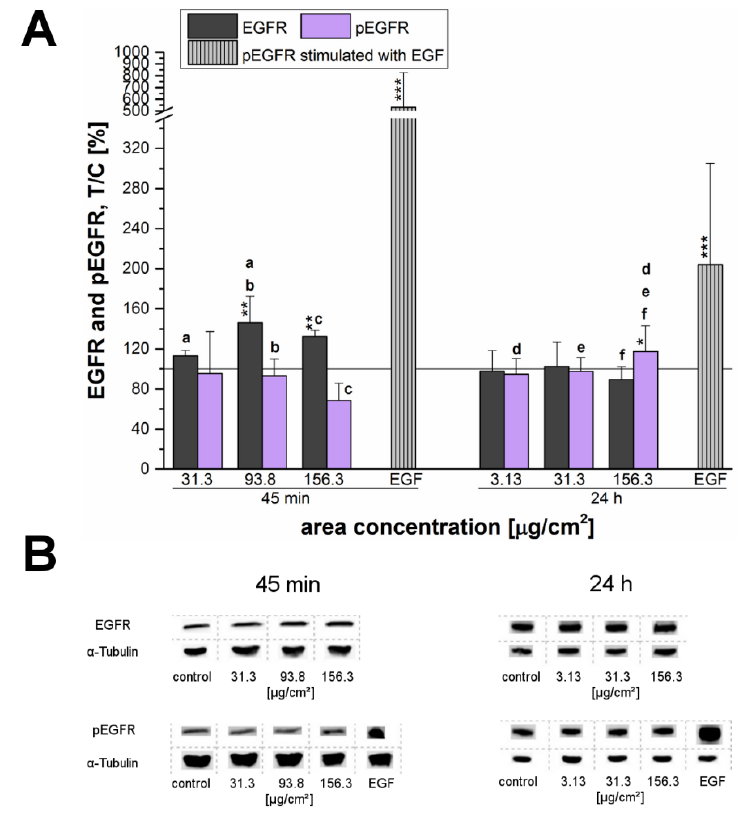
Figure 7. Endogenous epidermal growth factor (EGF) receptor levels and their activation status (pEGFR) in GXF251L cells after 45 min and 24 h of incubation with 12 nm SiO 2 NPs. EGF was applied as a positive control for phosphorylation of EGFR. ( A ) The relative amount was quantified as arbitrary light units in relation to the negative control (T/C [%]). The solid line represents the negative control set to 100%; ( B ) Representative images of a Western blot experiment. α-Tubulin was used as loading control and detected on the same membrane. Statistical analysis was obtained by one-way ANOVA followed by Fisher’s LSD test. Significances indicated as * refer to a comparison to the respective negative control (* ≡ p ≤ 0.05; ** ≡ p ≤ 0.01 and *** ≡ p ≤ 0.001; n ≥ 3). The same letters indicate a significant difference of these data with a statistical level of at least p ≤ 0.05.